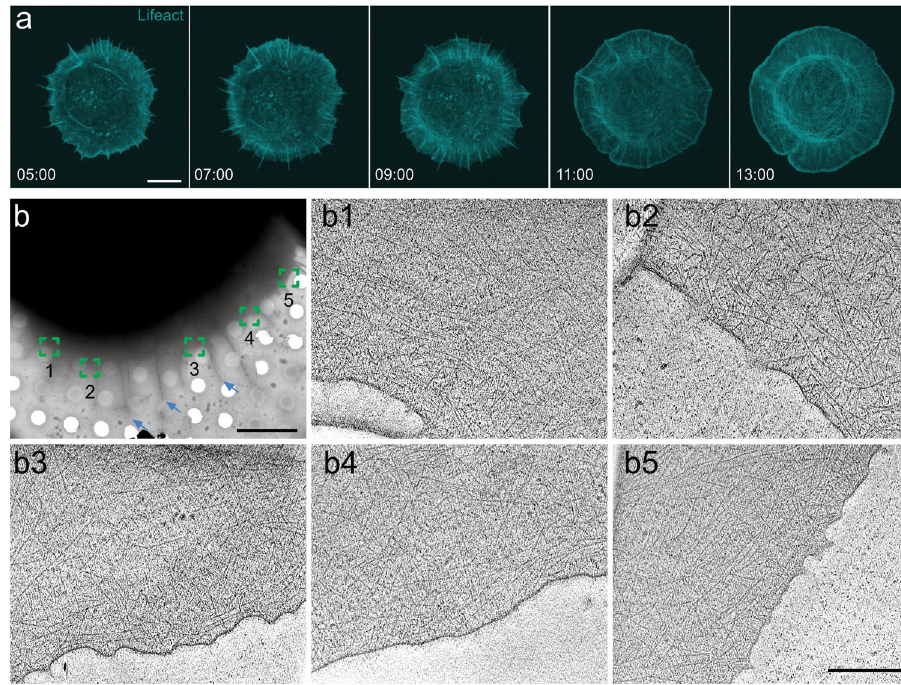
Fig. 1 Cell spreading on galectin-8 coated substrate. a Time-lapse images of a MEF cell transfected with Lifeact-mRuby let to spread on gal-8-coated substrate (Supplementary Movie 2). Scale bar: 10 μ m. b A cryo-EM image of a representative MEF cell spread on a gal-8-coated EM grid. Scale bar: 8 μ m. The area subjected to cryo-ET analyses indicated in boxes. A representative x-y slice through each tomogram in shown ( b1 – b5 ). Filopodia are indicated with cyan arrows. Scale bar: 300